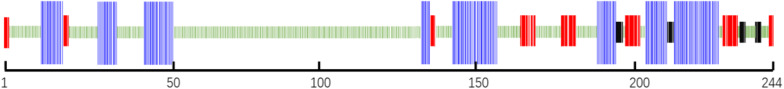
Secondary structure analysis of Mr-MagR. The blue parts represent 8 α-helix structures, the red parts represent 8 β-sheet structures, the black parts represent 4 β-turn structures, and the remaining green parts are random coil structures.